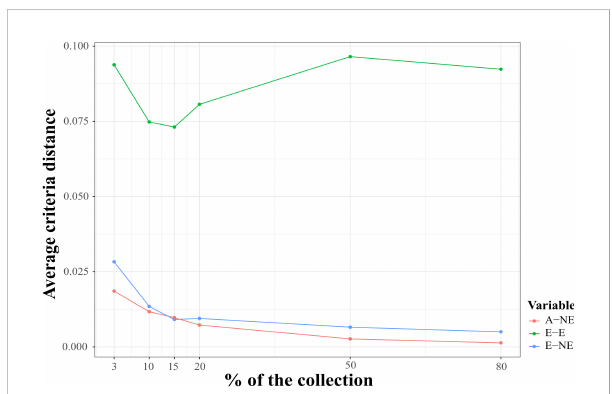
FIGURE 7 Evaluation of core quality using three different distance-based metrics for core identi fi cation and phenotypic data. The average criteria distance (y-axes) for three distance-based metrics A-NE (average Accession to Nearest Entry distance), E-E (average Entry to Entry distance), and E-NE (average Entry to Neatest Entry distance) calculated using phenotypic distance among core entries identi fi ed with A-NE criterion and genomic markers for six core collection sizes: 3, 10, 15, 20, 50 and 80 percent of whole samples genotyped in this study